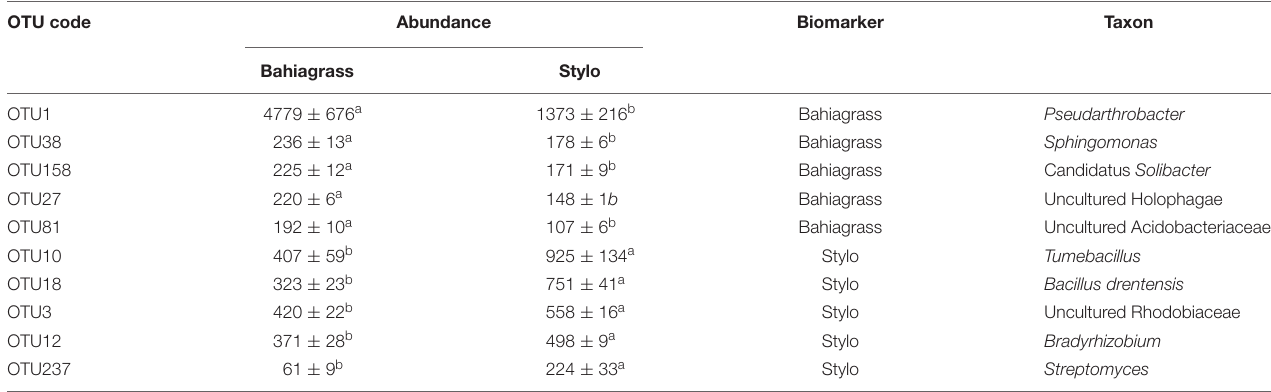
TABLE 2 | Biomarkers of different plant species as revealed by soil bacteria (OTUs) enriched in root compartment.